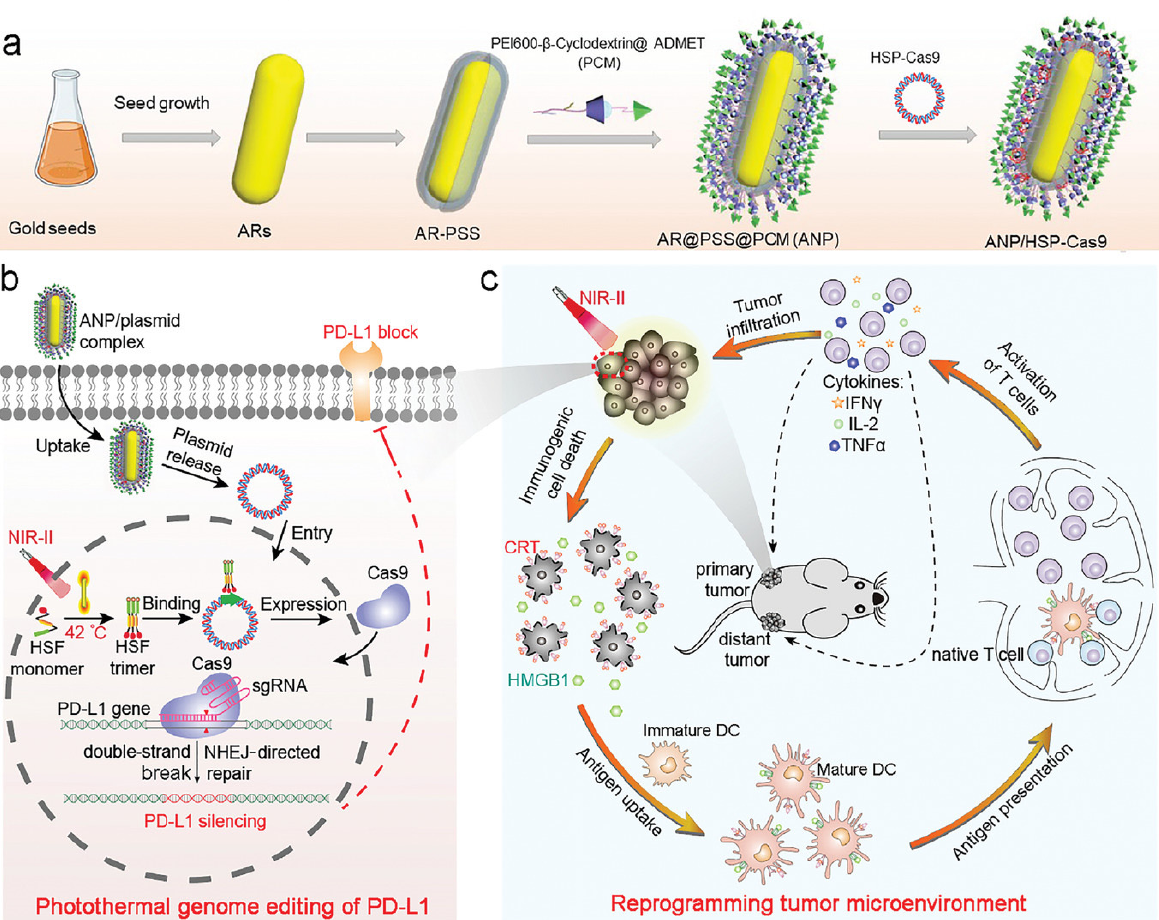
Figure 8. A schematic diagram of MNP-mediated ICD, tumor antigen release, and DC maturation. ( a ) Synthesis of the ANP/HSP-Cas9 complex. ( b ) Photothermal activation of PD-L1 genome editing. ( c ) NIR laser-induced photothermal therapy triggers ICD and antigen presentation, thereby activating the T cells. Reproduced with permission from [20] published by John Wiley and Sons, 2021